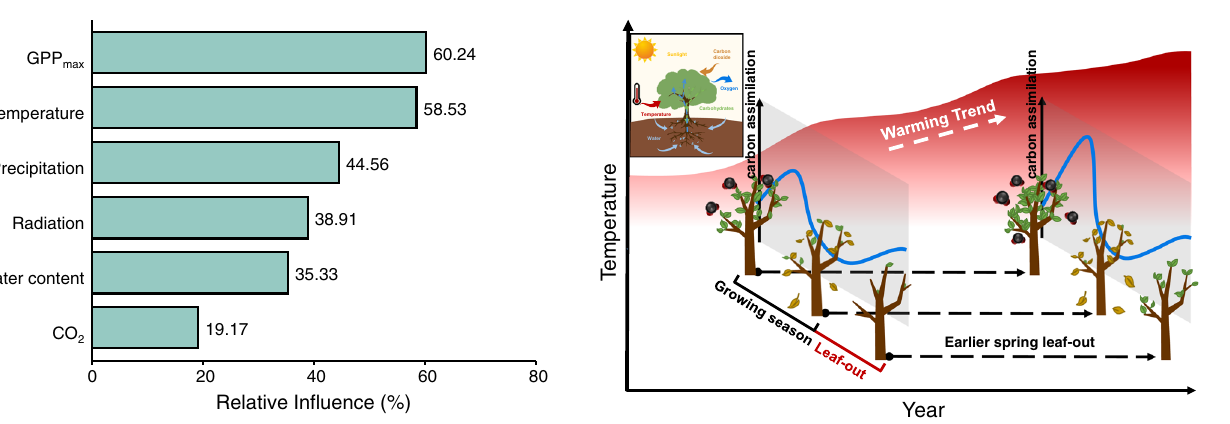
Fig. 6 A schematic diagram of the earlier spring phenology in response to warming of previous growing season. Warmer temperatures during the previous growing season drivers earlier spring phenology by increasing photosynthetic carbon